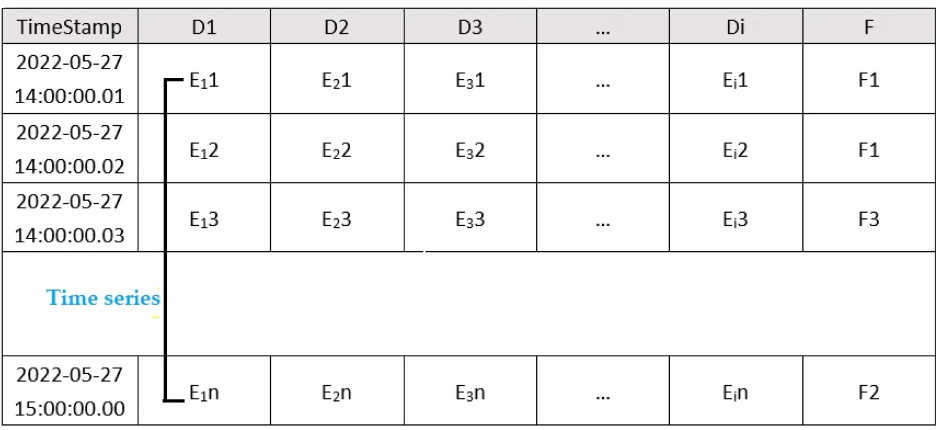
Figure 2. The structure of the issue and multi-dimensional time